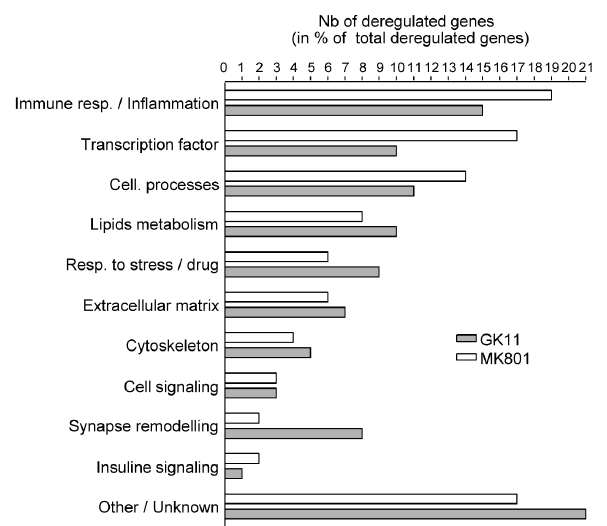
Figure 3. Using IPA software and analysis of the literature, the genes deregulated by either MK801 or GK11 treatment were each allocated one main biological function. Each bar represents the number of genes (expressed as the percentage of the total number of deregulated genes after each treatment) assigned to each specific biological function. Although the functions of a significant number of genes affected by the NMDAR antagonists are unknown, the most affected biofunction corresponds to the inflammatory and immune response